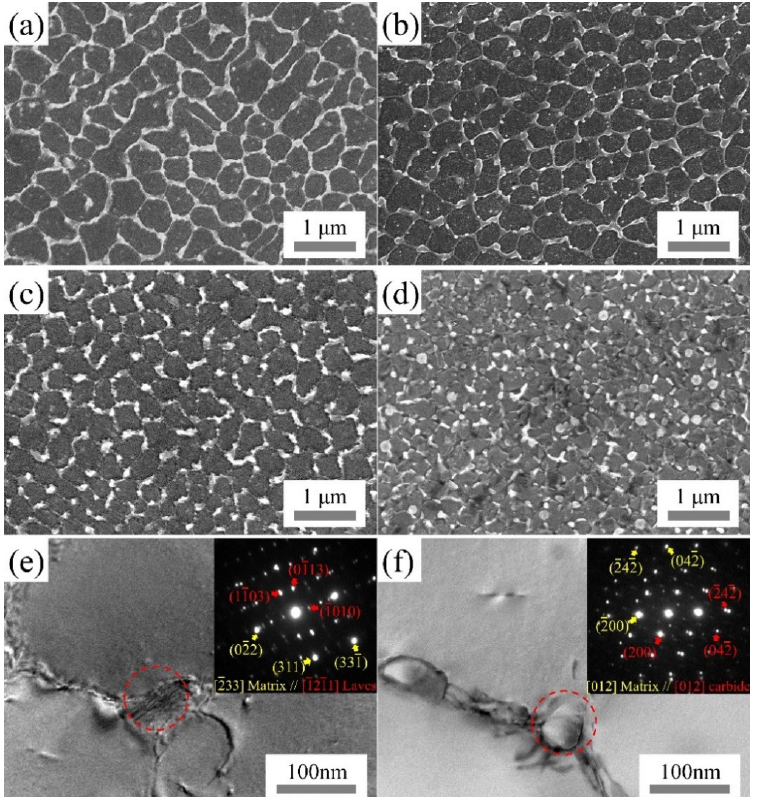
Figure 4. As-built cellular structure observed under SEI ( a ) without NbC, ( b ) with 0.5% NbC, ( c ) with 1.0% NbC, and ( d ) with 5.0% NbC in weight. TEM bright field images and diffraction patterns, ( e ) Laves phase was identified in the sample without NbC, and ( f ) cubic carbide was identified with NbC